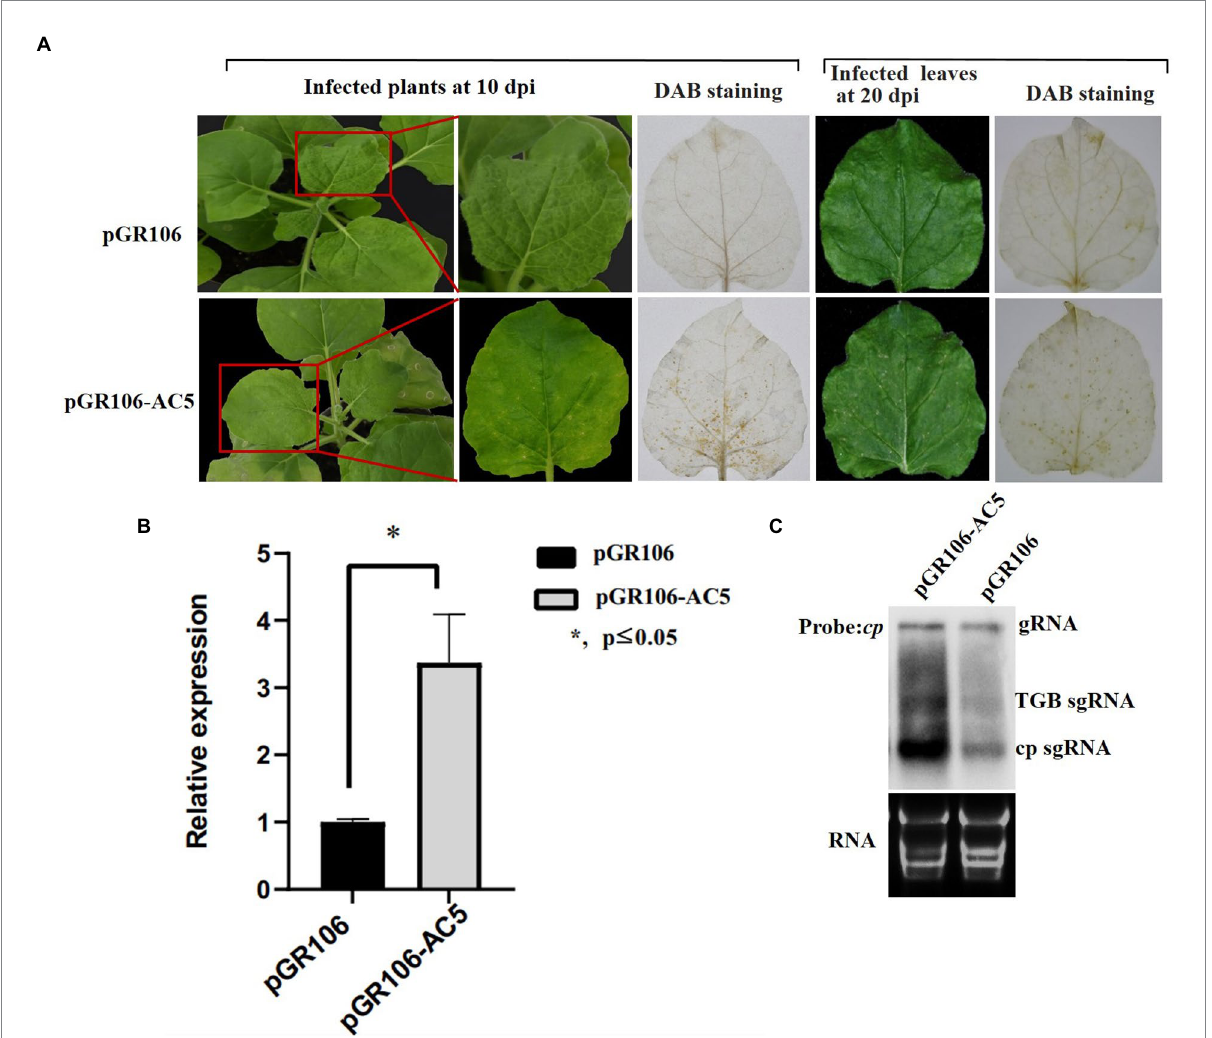
FIGURE 7 Symptoms exhibited by plants following inoculation with pGR106 or pGR106-AC5. (A) N . benthamiana plants inoculated with pGR106 or pGR106- AC5 were photographed at 10 day-post Agrobacterium -infiltration (dpai). Upper infected leaves were photographed directly at 10 dpi and 20 dpi or photographed after 3,3 ′ - diaminobenzidine (DAB) staining. (B) Leaf tissues were harvested from pGR106- or pGR106-AC5-systematically infected N . benthamiana plants at 10 dpai. The mRNA accumulation of potato virus X (PVX) was analyzed using real-time qPCR. * p ≤ 0.05, Student’s t